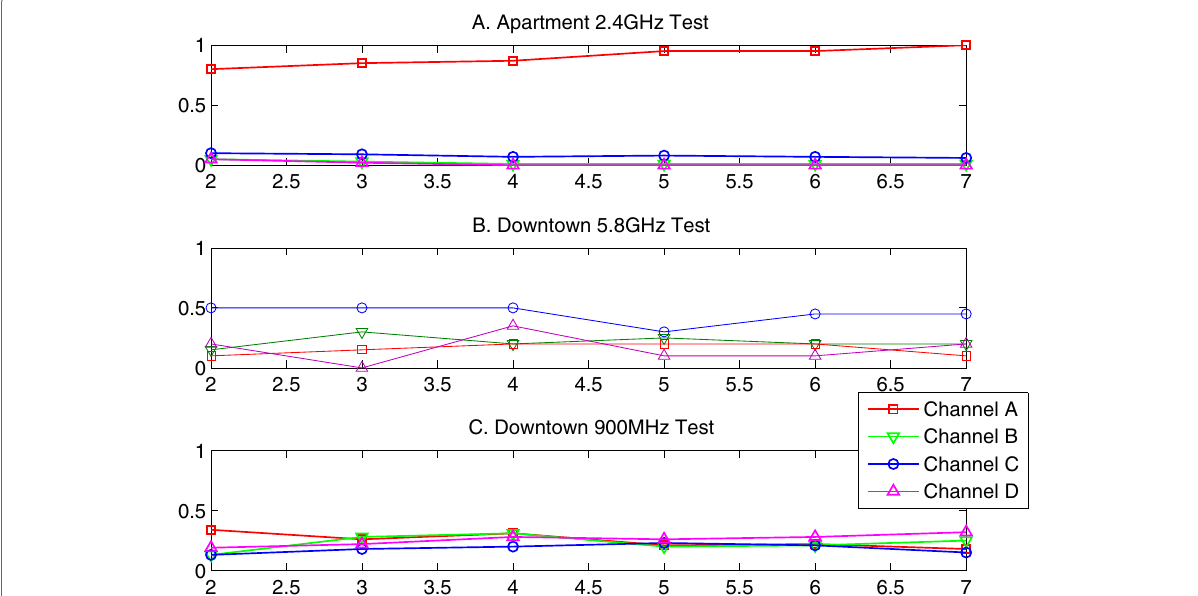
Fig. 10 Confidence of inference at different locations. The confidence of selecting a known channel for in-field channels is calculated with the channel inference